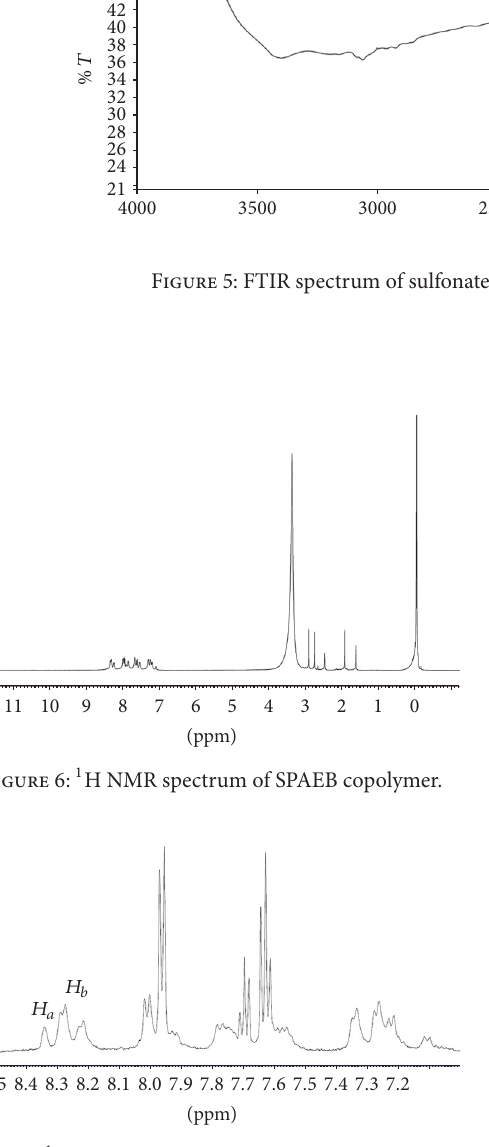
Figure 7: 1 H NMR spectrum of SPAEB oleum (SO 3